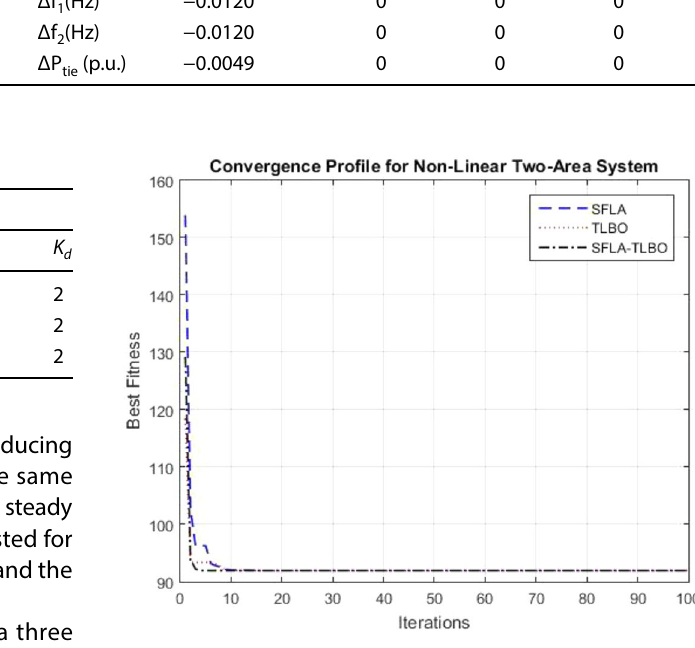
Fig. 10 Convergence profile for non-linear two-area